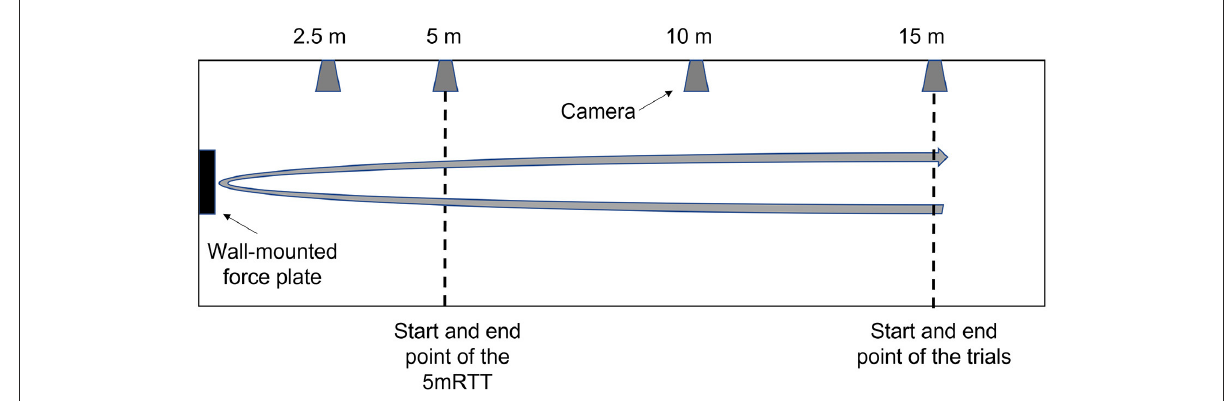
FIGURE2 Experimental setup, displaying the location of the wall-mounted force plate (black rectangle) and the four cameras (gray trapezoids).